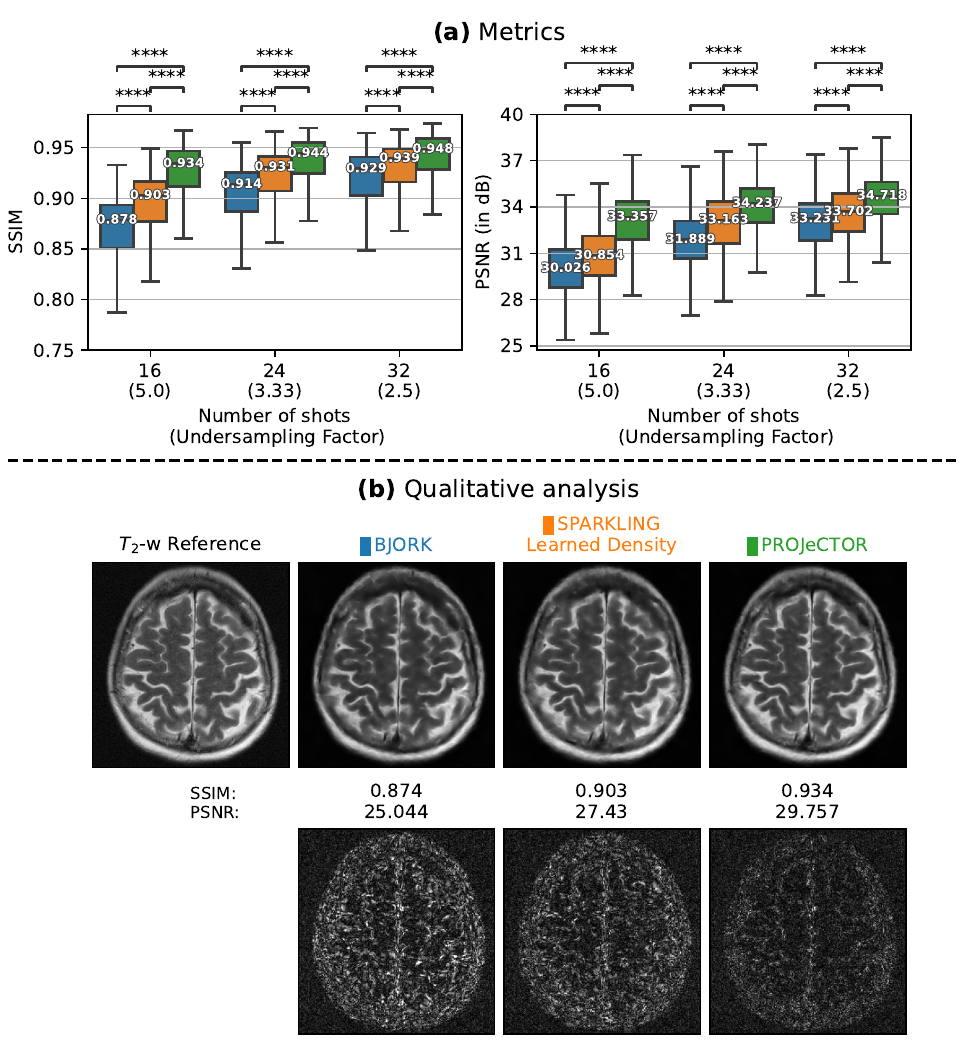
Figure 4. ( a ) Box plots comparing the image reconstruction results on a retrospective study us- ing 512 slices on T 2 contrast (fastMRI validation dataset) using BJORK (blue), SPARKLING with learned density (orange) and PROJeCTOR (green). The median values of these metrics are high- lighted inside the box plots. We present the results at varying UF characterized with N c = 16, 24 and 32. SSIMs/PSNRs appear at left/right. The significance levels are indicated as paired t - test and are all significant with p < 10 − 4 (Significance level indicated with **** between groups in box plots). ( b ) Top: T 2 -w reference image and reconstruction results for a single slice from file_brain_AXT2_205_2050175.h5 with corresponding strategies. ( b ) Bottom: The residuals maps, scaled to match and being compared across